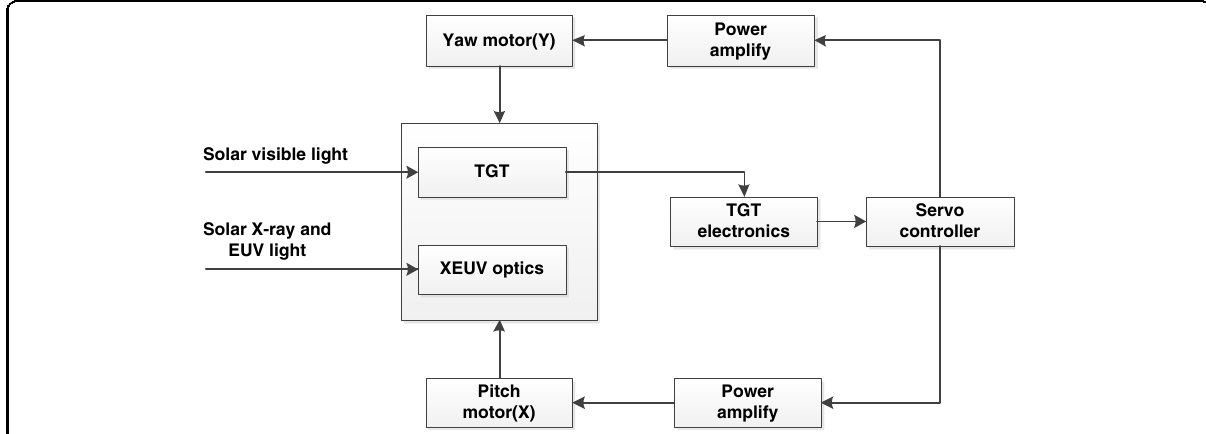
Fig. 13 Schematic diagram of the Sun tracking